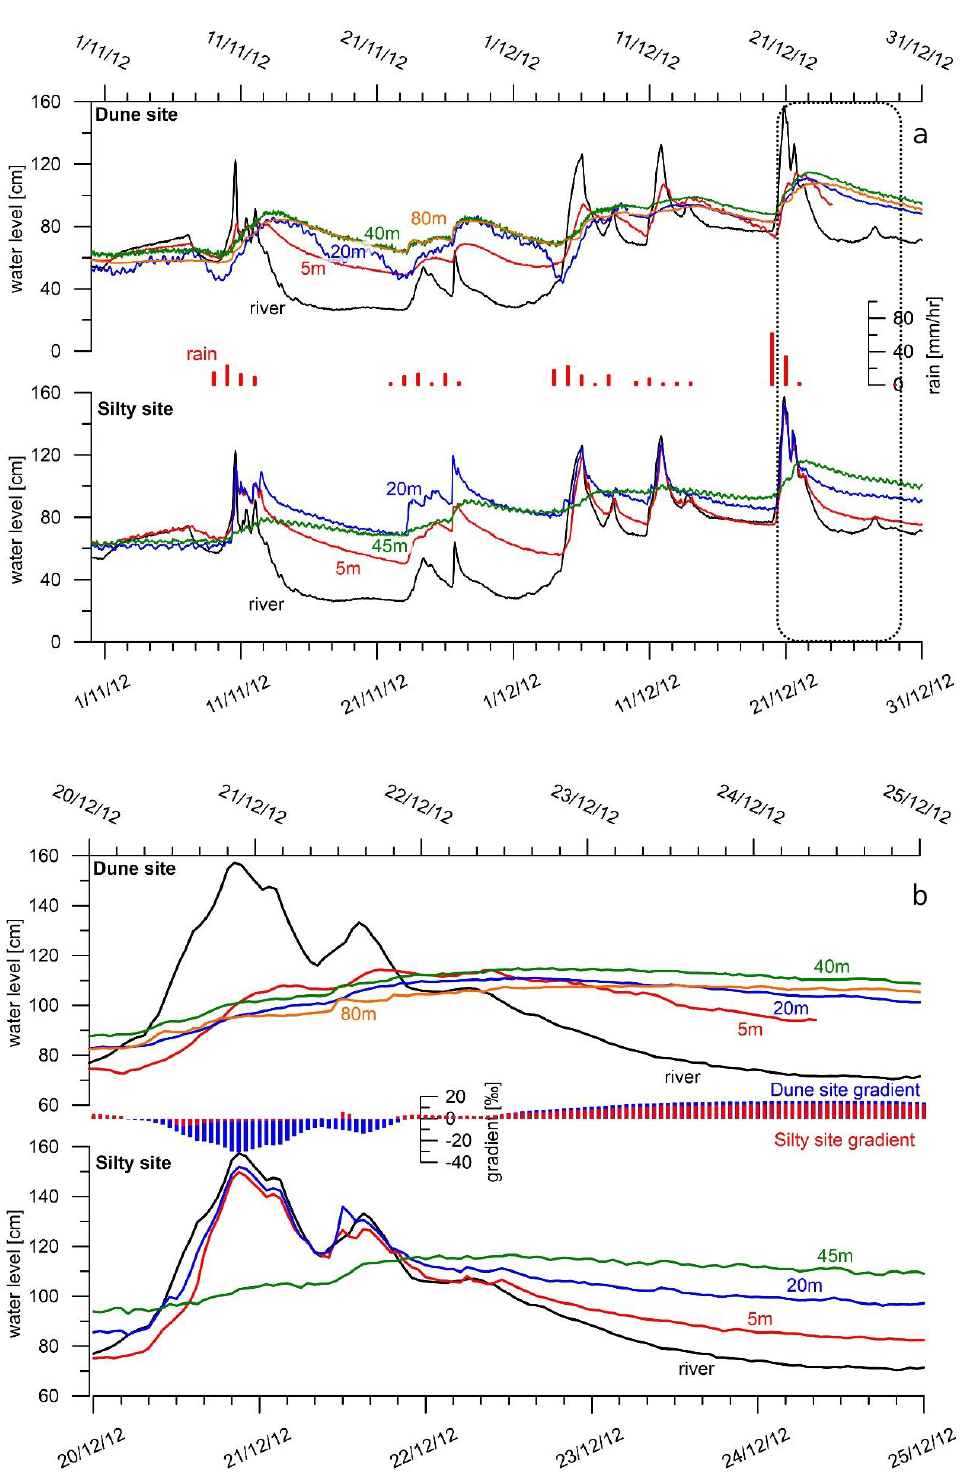
Figure 4. ( a ) An enlargement of Figure 3 for early winter, 2012. ( b ) Zoom-in into a single winter river event (late December 2012). Also shown in ( b ) is the aquifer–river gradient. Numbers denote distance from the river in meters.